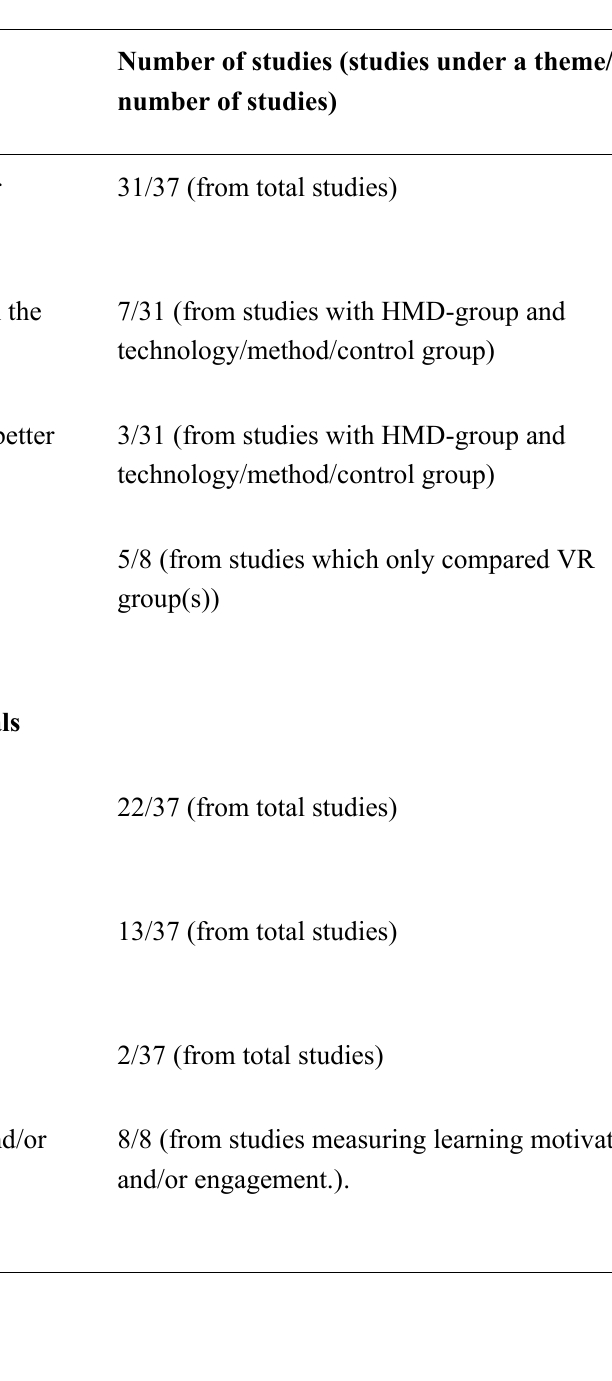
Summary from the Analysis (n =